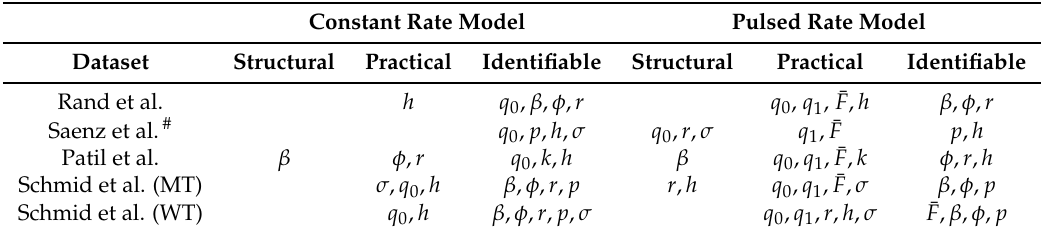
Table 1. Identifiability characteristics of the fitted parameters. We categorize each fitted parameter as structural non-identifiable (structural), practically non-identifiable (practical) or identifiable.